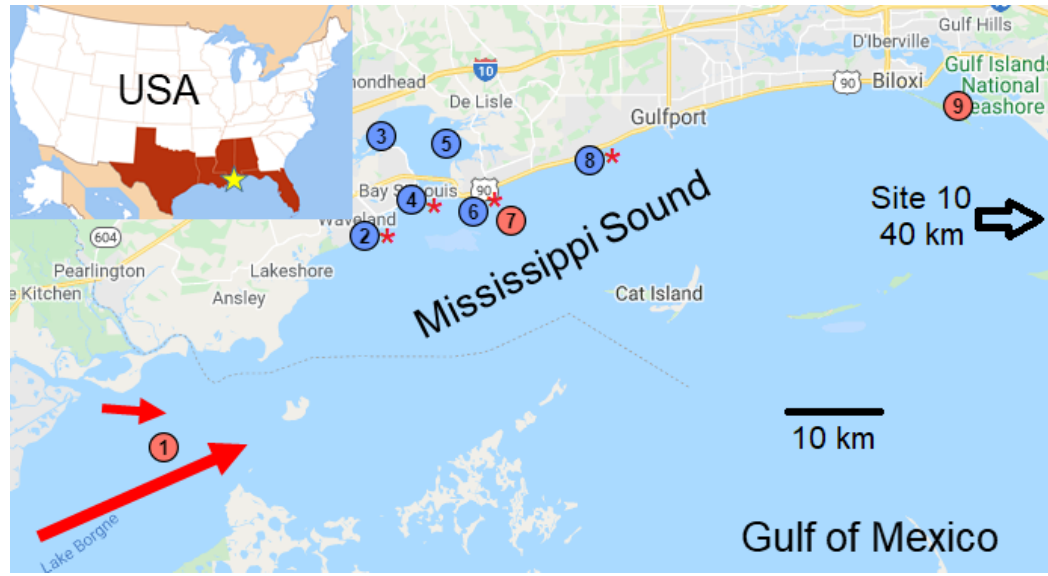
Figure 1. Map showing the sampling locations (circles) in the Mississippi Sound with direction of freshwater inflows from the Bonnet Carré Spillway and the Pearl River (red arrows). Sample site numbers increase from west to east. Sampling sites 2, 4, 6, and 8 (red stars) were at oyster reefs. Red circles represent sites where samples were collected by the Mississippi Department of Environmental Quality, and blue circles sites where samples were collected by the University of Mississippi. Site 10 is off the map, about 40 km to the east in Alabama waters. The inset shows the general study location within the USA. Table 1. Geographic coordinates for sites where water was collected along the Mississippi Gulf Coast for microplastic analyses. Sites are listed west to east, with site numbers depicted in Figure 1. GPS Coordinates Depth (m) Site # Site Name Reef Site